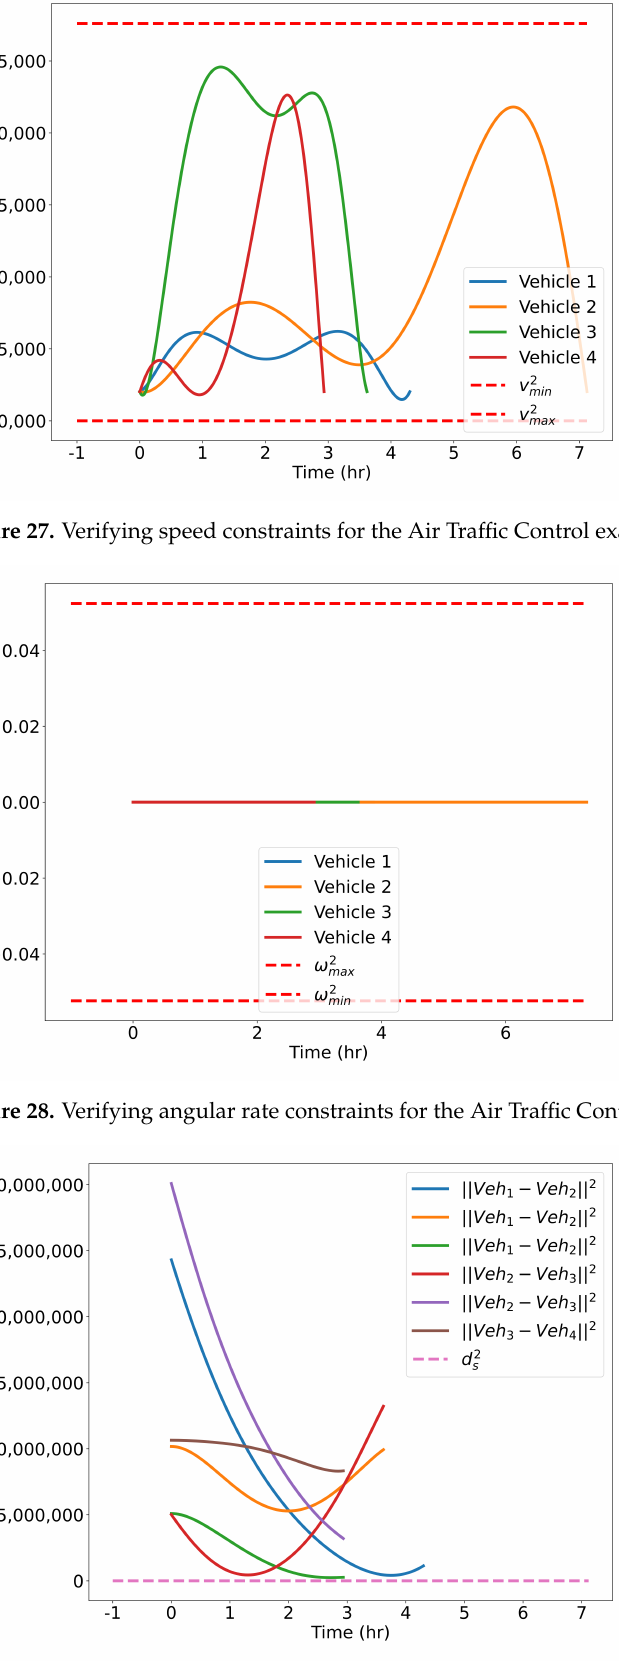
Figure 29. Verifying minimum safe distance constraints for the Air Traffic Control